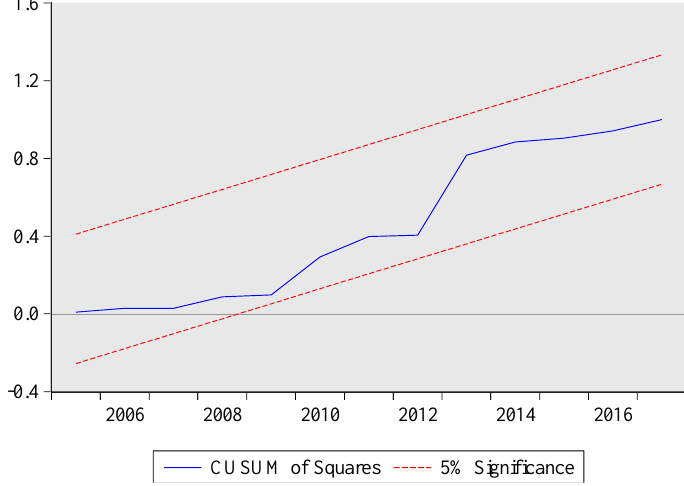
Figure 4. CUSUMSQ test for Model 1. The plot of the cumulative sum of squares of the recursive residuals. Note: The red dashed lines represent the critical bounds at the five percent significance level.